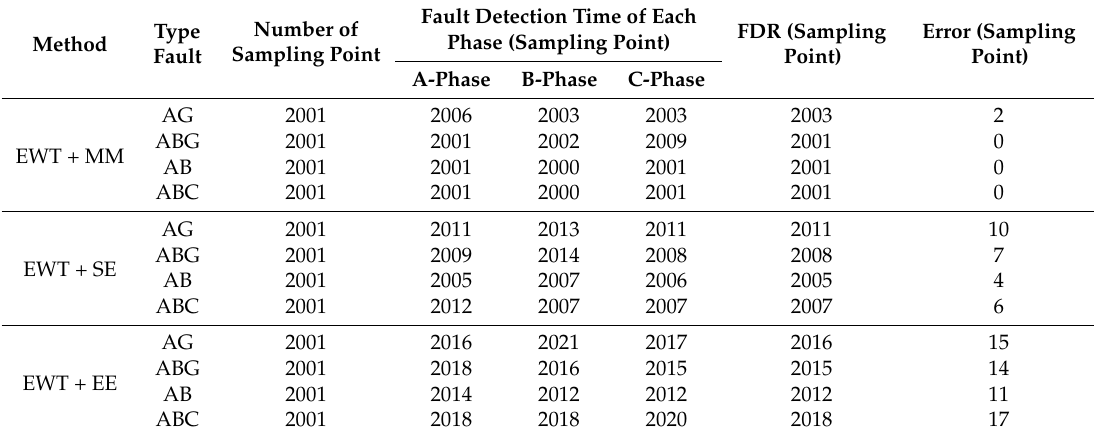
Table 2. Comparison of short-circuit fault detection results with different